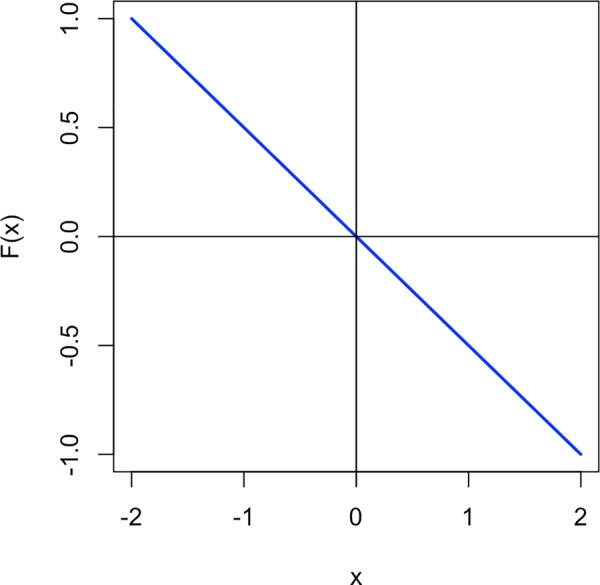
Graph of the function F(x) from (1).